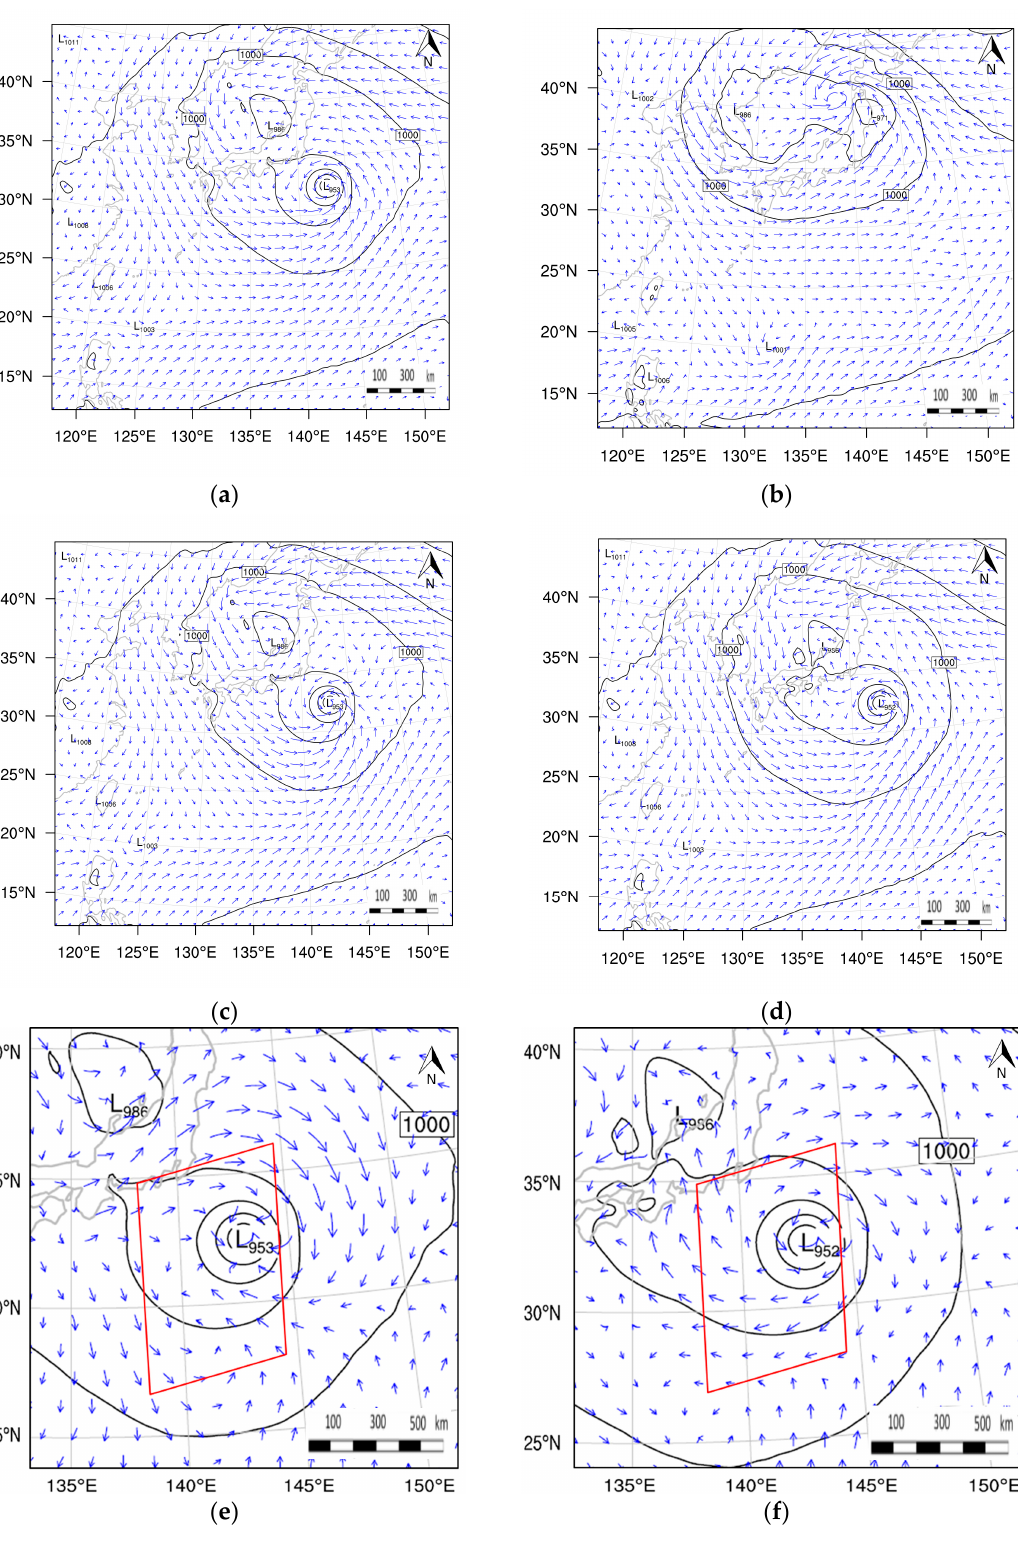
Figure 5. The 10m wind field at 0900 UTC 29 August 2016 from ( a ) the NCEP FNL data in ( b ) the background field; the wind analysis field at 10m from ( c ) SAR_sd and ( d ) SAR_uv. The bottom two panelsare the analysis bias derived from the analysis subtracting the FNL data for ( e ) SAR_sd and ( f ) SAR_uv. The red frames mark the area of the SAR wind observations. Note the different spatial scales of ( e , f ) as compared to ( a – d ).